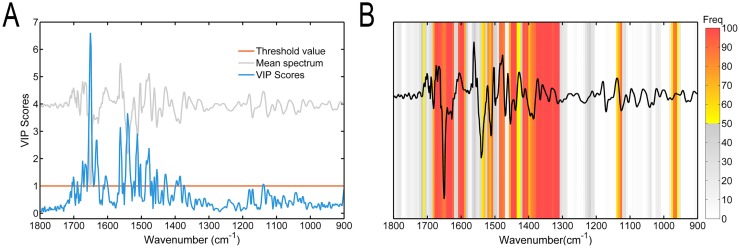
The results of VIP scores and GA-PLS.(A) VIP score distribution for the investigated spectral region 1800–900 cm–1. The gray line shows the average preprocessed spectrum, and the orange line shows the threshold value. (B) Frequency of the selection of different wavenumbers in the 100 runs of GA-PLS. The average preprocessed spectrum is superimposed on the frequency.